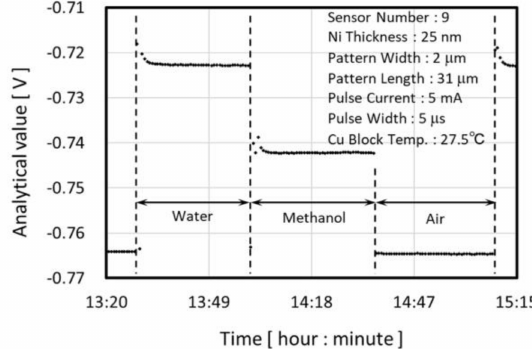
Figure 17. Example of the analytical value during the detection performance evaluation.